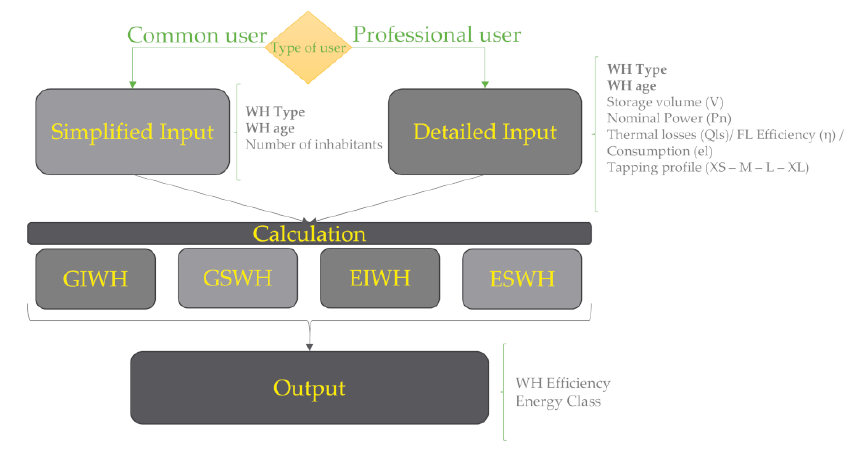
Figure 3. Block diagram of labeling of water